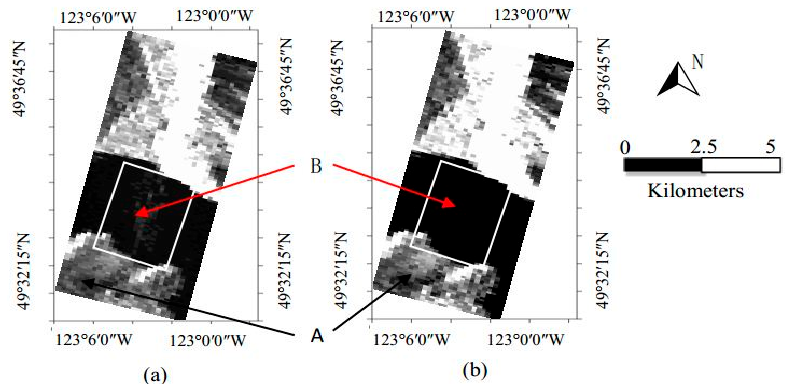
Figure 11. Subimage of Frame 2 in Figure 10, ( a ) conventional SAR image; ( b ) estimated NRCS image.